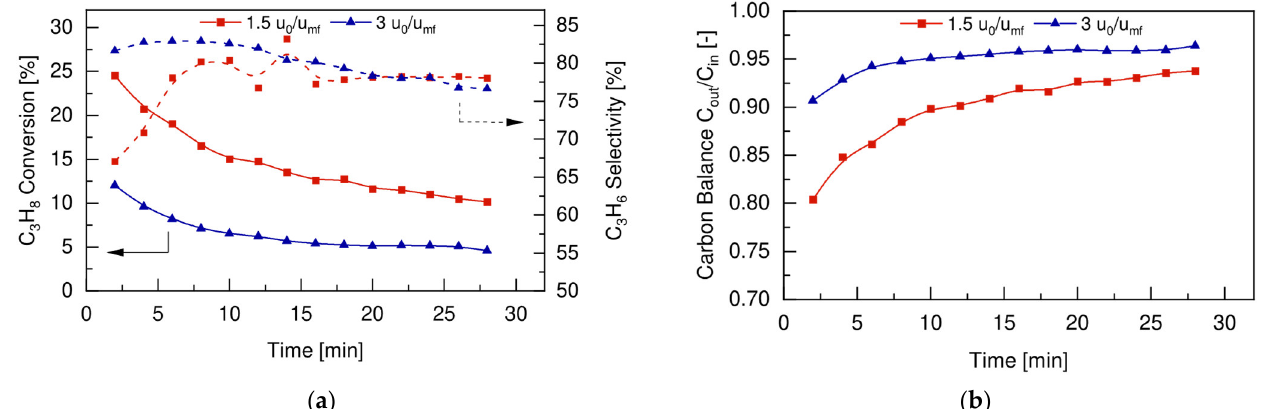
Figure 8. Fluidized bed membrane reactor ( a ) performance and ( b ) carbon balance for different u 0 /u mf ratios, at 500 °C, 2 bar and with a feed composition of 30vol% C 3 H 8 -70 vol% N 2 .